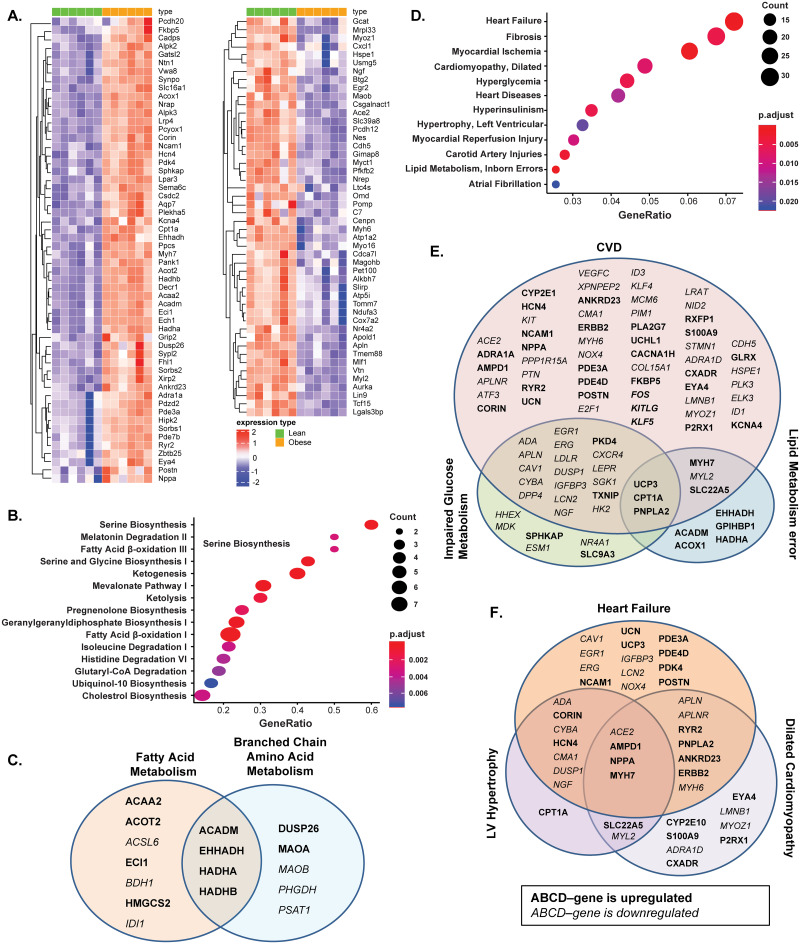
Gene expression analysis of RNA extracted from left ventricle (LV) of 20-week-old obese and lean ZSF1 male rats.The gene expression analysis of RNA revealed increased expression of 56 heart abundant genes and decreased expression of 48 heart abundant genes; the heatmap represents the individual expression changes in obese vs lean ZSF1 rats (A). Ingenuity pathway analysis (IPA) of enriched metabolic pathways (B) and comparison of differentially expressed genes (DEGs) presented in the enriched metabolic pathways from IPA over-represented cardiometabolic Medical Subject Headings (MeSH) terms (C). IPA of 267 significantly increased (FC > 1.5, Benjamini-Hochberg corrected p-value < 0.05) and 431 significantly decreased genes (FC < 2/3, p-value < 0.05) in LV of obese ZSF1 rats (D); comparison of DEGs enriched in cardiovascular disease (CVD), impaired glucose metabolism, and lipid metabolism error disease pathways (E); and comparison of DEGs associated with different subgroups of heart disease pathways from over-representative MeSH term analysis (F). Gene symbols in bold indicate increase of expression and in italic indicate decrease of expression. n = 8 for lean and n = 8 for obese ZSF1 groups.